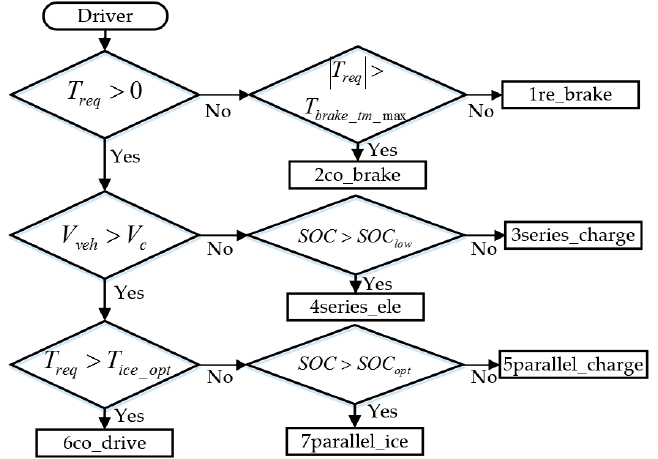
Figure 2. Logic threshold energy management strategy.